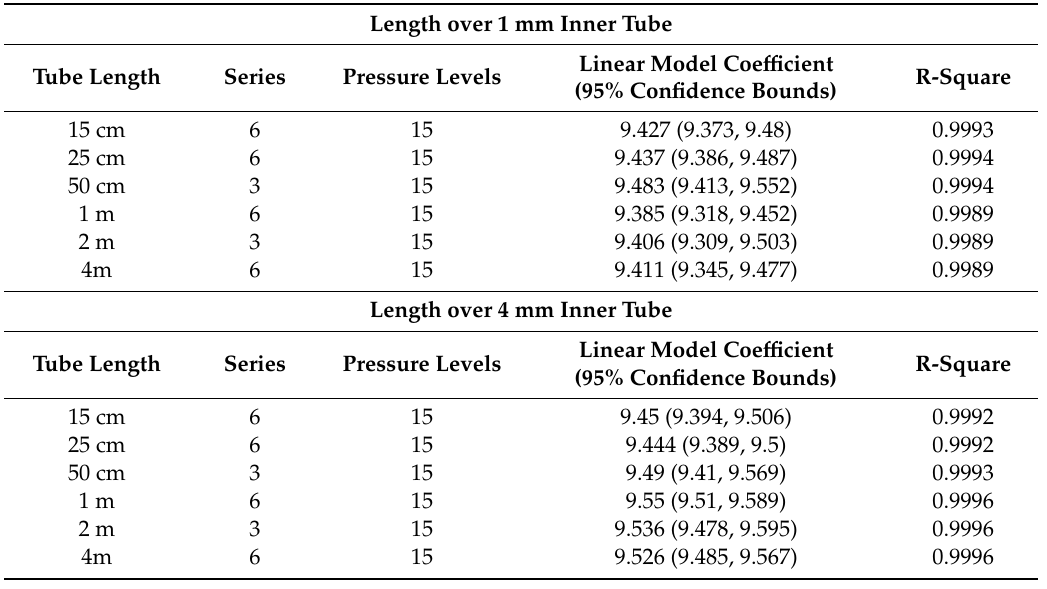
Table 3. Linear regression coefficients for each experiment.